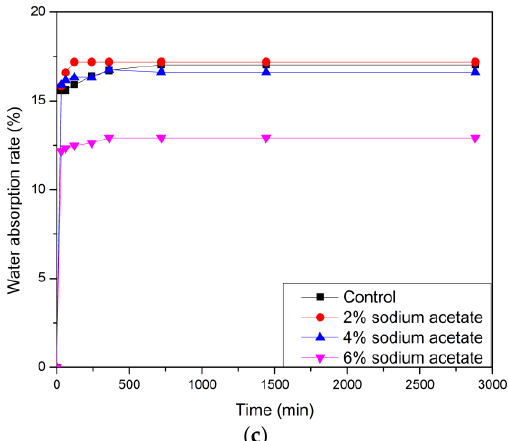
Figure 3. Water absorption rates PCC pavement after 28 days of curing in: ( a ) water bath, ( b ) natural environment (outdoor), and ( c ) pond